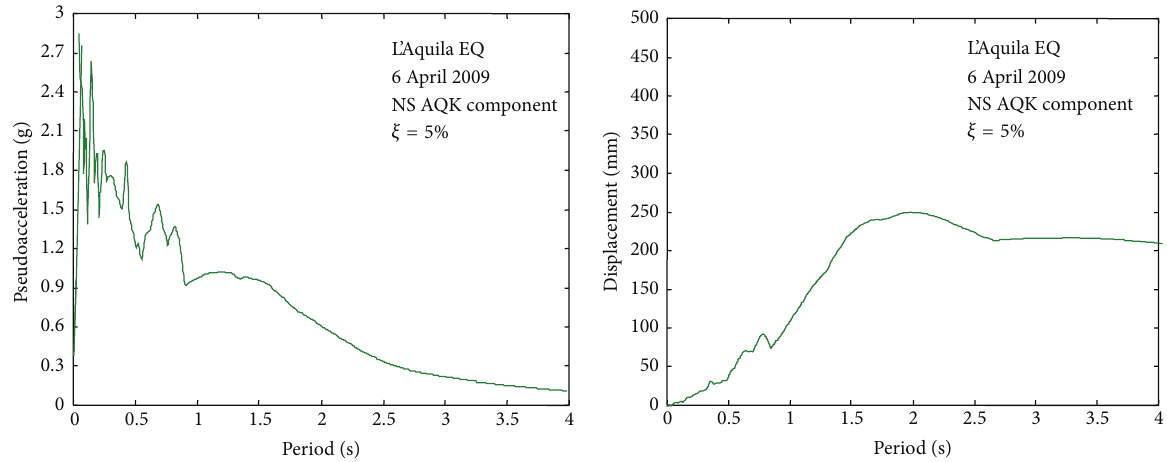
Figure 11: Pseudoacceleration and displacement elastic response spectra at 𝜉 = 5 % of NS AQK component—L’ Aquila earthquake of 6th of April